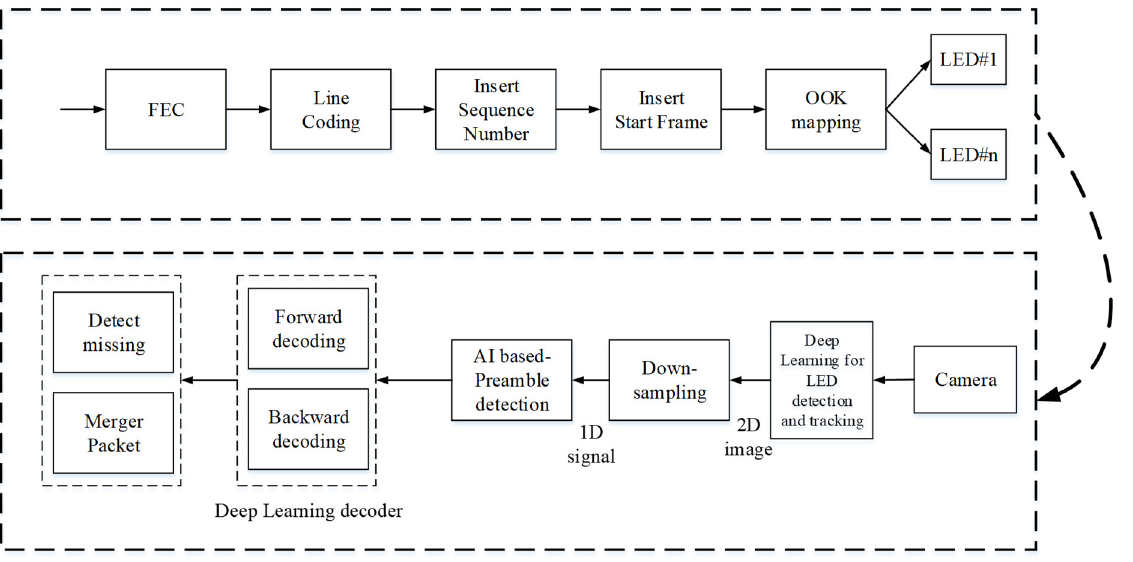
Figure 1. MIMO C-OOK architecture based on a deep learning neural network.